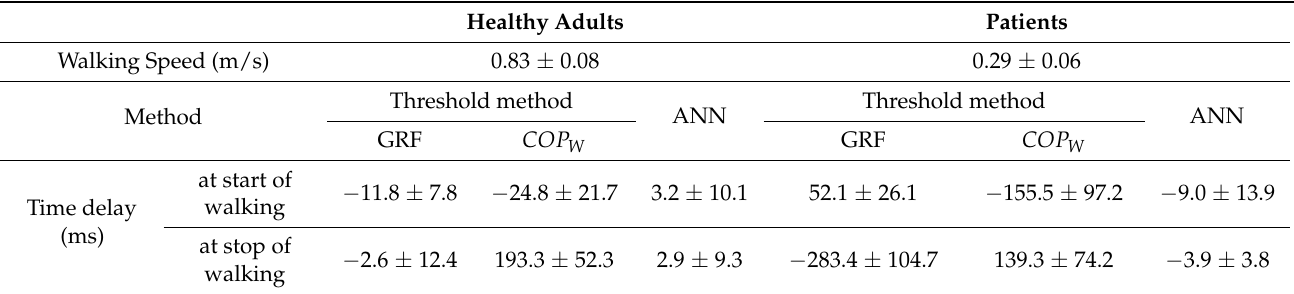
Figure 11. Comparison of the classification results using the test data: ( a ) healthy adults ( b ) patients. Table 3. Variation of time delay in the gait